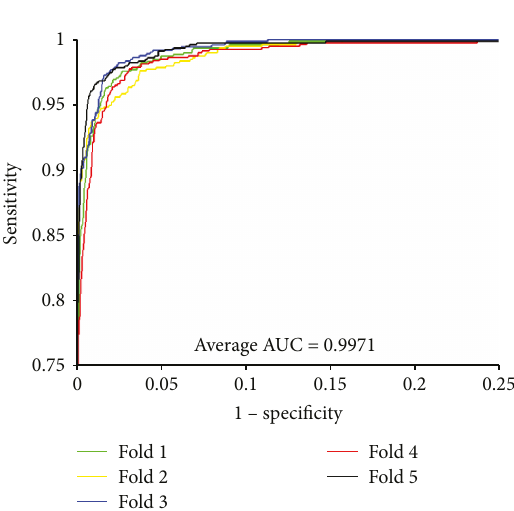
Figure 3: ROC curves performed by the proposed approach on the unbalanced-human